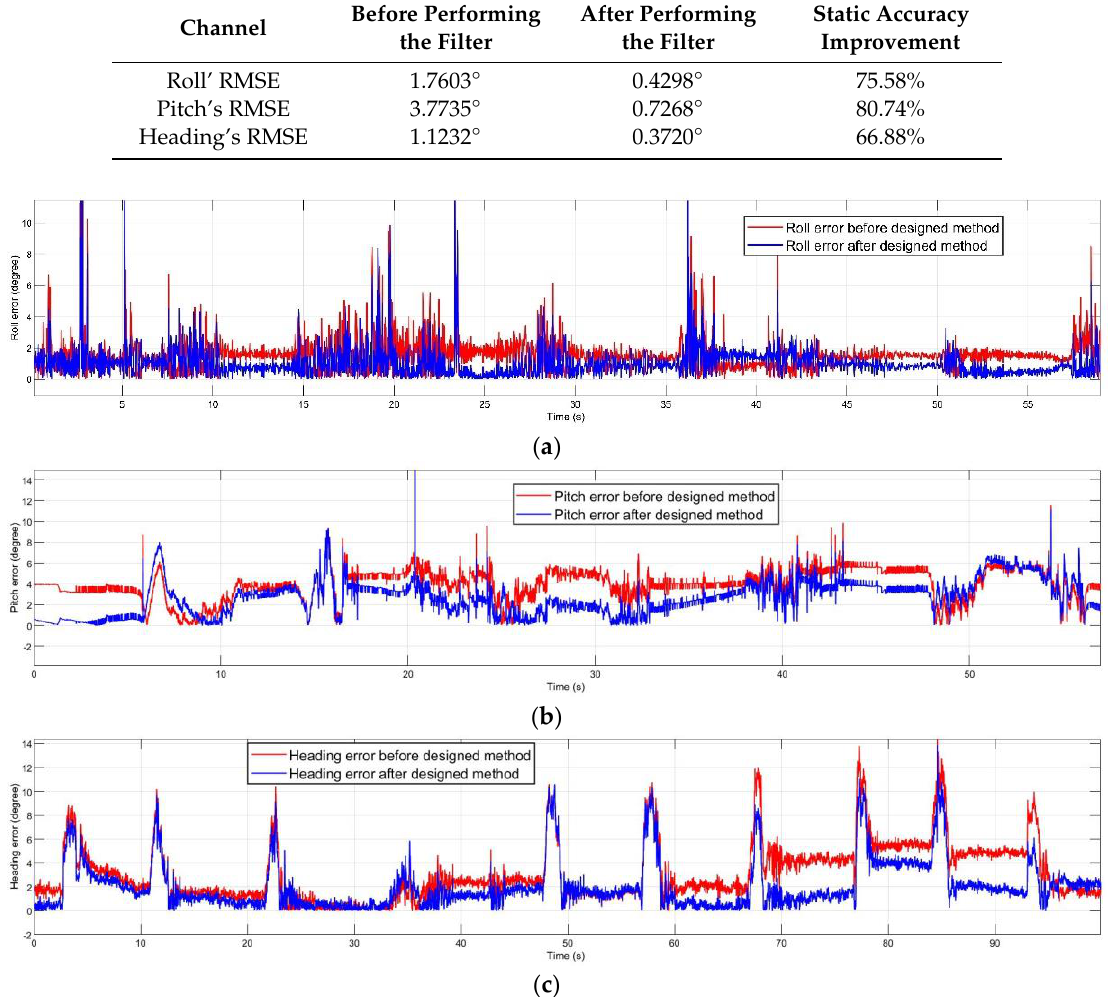
Figure 6. Absolute error before and after performing the proposed filter: ( a ) roll; ( b ) pitch; ( c ) heading.